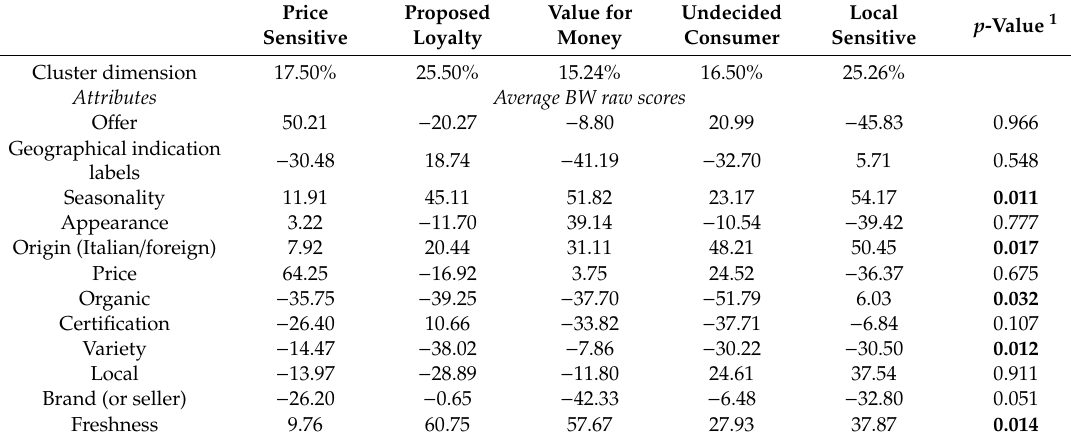
Table 5. The average BW raw score for each fruit and vegetable attribute resulting from the five clusters of consumers: price sensitive, proposed loyalty, value for money, undecided consumer, and local sensitive. Price Value for Sensitive